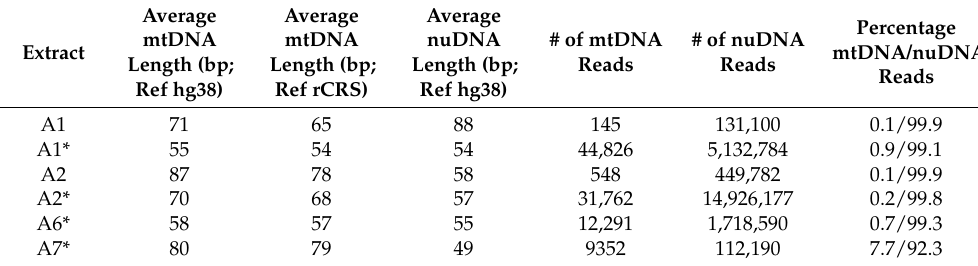
Table 9. Sequencing statistics for single aged hairs. The asterisk denotes DNA extraction using protocol B [26].